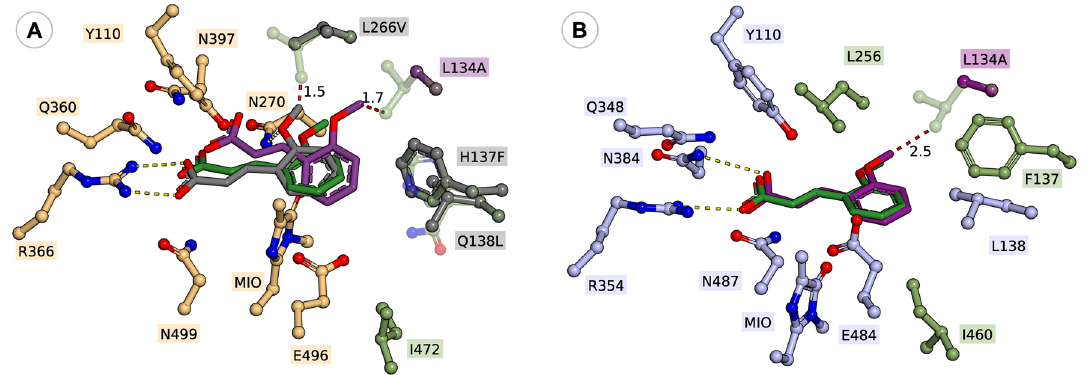
Figure 3. 2-Methoxycinnamic acid 2c docked into the active site of: ( A ) wt - Rt PAL (green, − 4.2 kcal/mol), L134A Rt PAL (purple, − 6.9 kcal/mol), and H137F/Q138L/L266V Rt PAL (grey, − 8 kcal/mol); ( B ) wt - Pc PAL (green, − 7.3 kcal/mol) and L134A Pc PAL (purple, − 7.7 kcal/mol). Steric clashes between the ortho -methoxy group and side chains of residues L266 and L134, respectively, are highlighted with red dashed lines. The modified residues and the active site orientation of 2c within the corresponding PAL variant is marked with similar